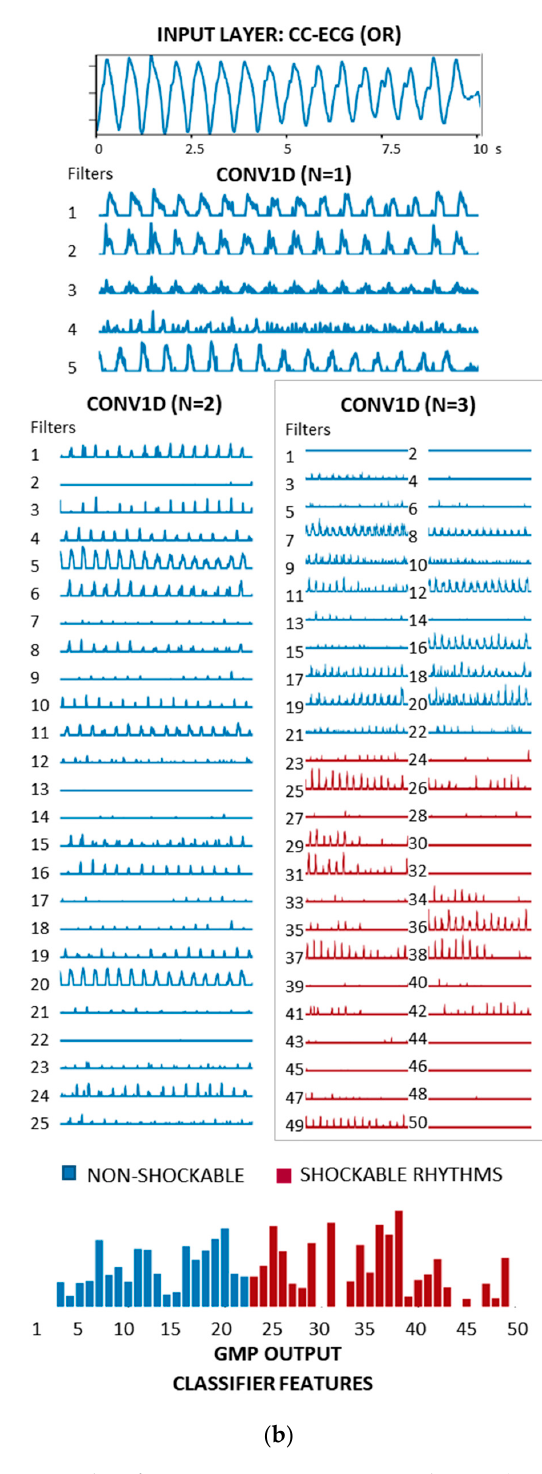
Figure 9. Features of CNN3-CC-ECG network computed for two examples of 10 s ECG-CC strips annotated as OR (Figure 1) with different shock advisory decisions: ( a ) OR (SNR = − 14.6 dB) correctly detected as NSh rhythm with output probability pSh = 0.001; ( b ) OR (SNR = − 18.4 dB) erroneously detected as Sh rhythm with output probability pSh = 0.858. The underlined 50 filters at the output of CONV1D (N = 3) are used for computation of 50 classifier features (bottom plot), grouped for Sh (red) and NSh (blue) rhythms in accordance with the sign of the classifier